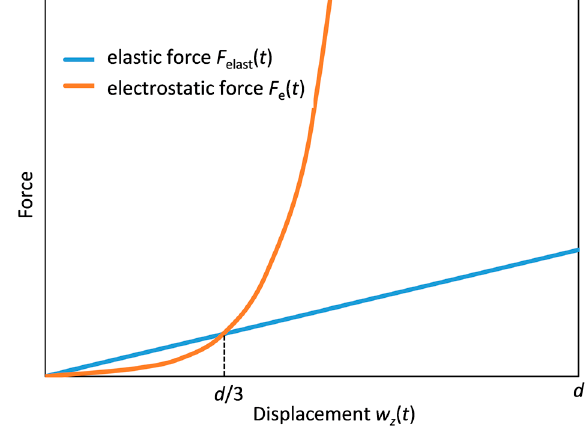
Figure 2. Schematic of forces as a function of displacement.